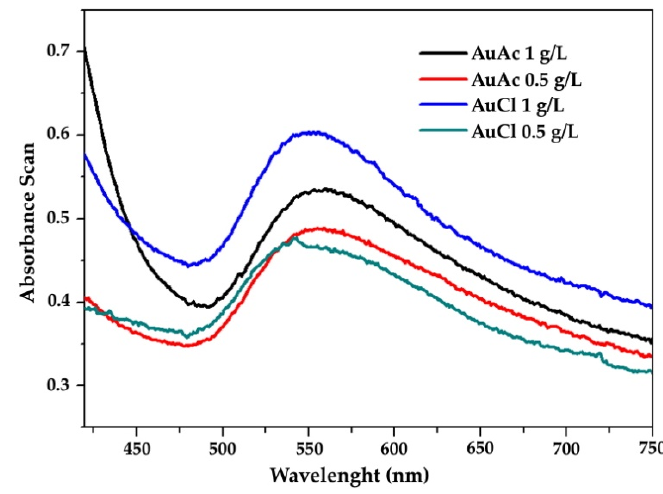
Figure 5. UV–Vis spectra of different concentrations of AuNPs.